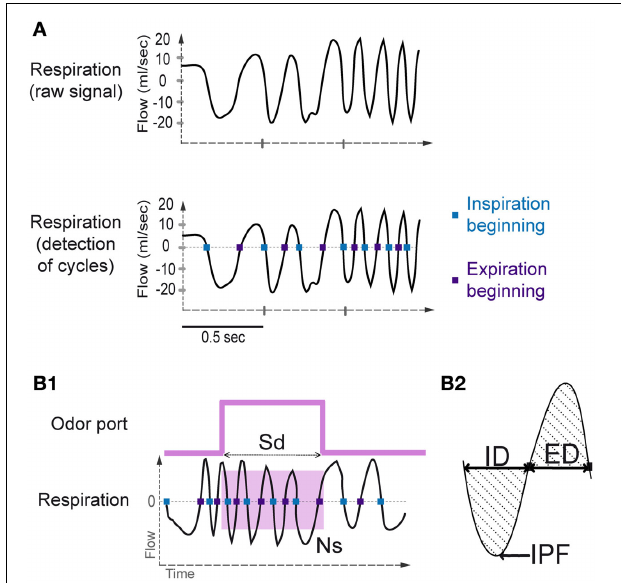
FIGURE 2 | Sniffing signal processing. (A) Top: Raw sniffing signal recorded by the plethysmograph. An algorithm was applied to detect the zero-crossing points. Bottom: The blue squares represent the detection of the beginning of the inspiratory phase, and the violet squares represent the beginning of the expiratory phase. (B1) Sampling duration and number of sniffs. Sampling duration (Sd) is defined as the time spent in the odor port. The number of sniffs (Ns) is defined as the number of sniffs occurring during the sampling period (pink square). (B2) A representative sniff cycle is shown to illustrate the parameters measured: inspiration duration (ID), expiration duration (ED), and inspiration peak flow rate